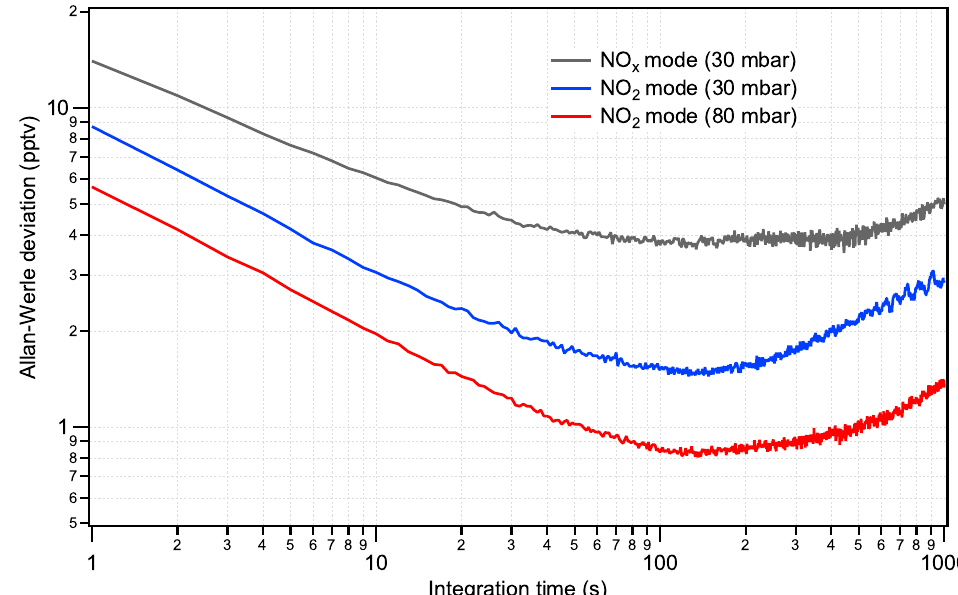
Figure 4. Allan–Werle deviation plot (1 σ ) of 12h measurements of NO 2 equivalent amount fraction obtained by sampling NO 2 -free synthetic air at different sample pressures (30 and 80mbar) and two distinct operation modes (NO x and NO 2 mode).